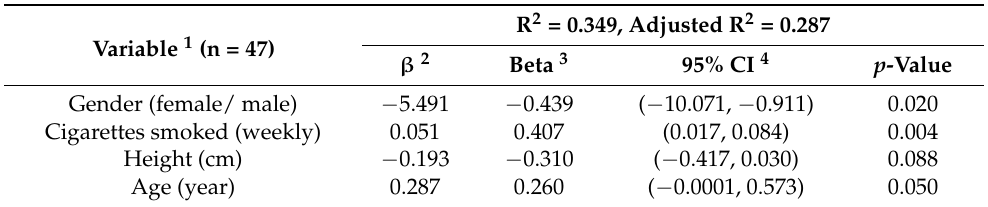
Table 4. Factors affecting baseline CO concentration in smokers.